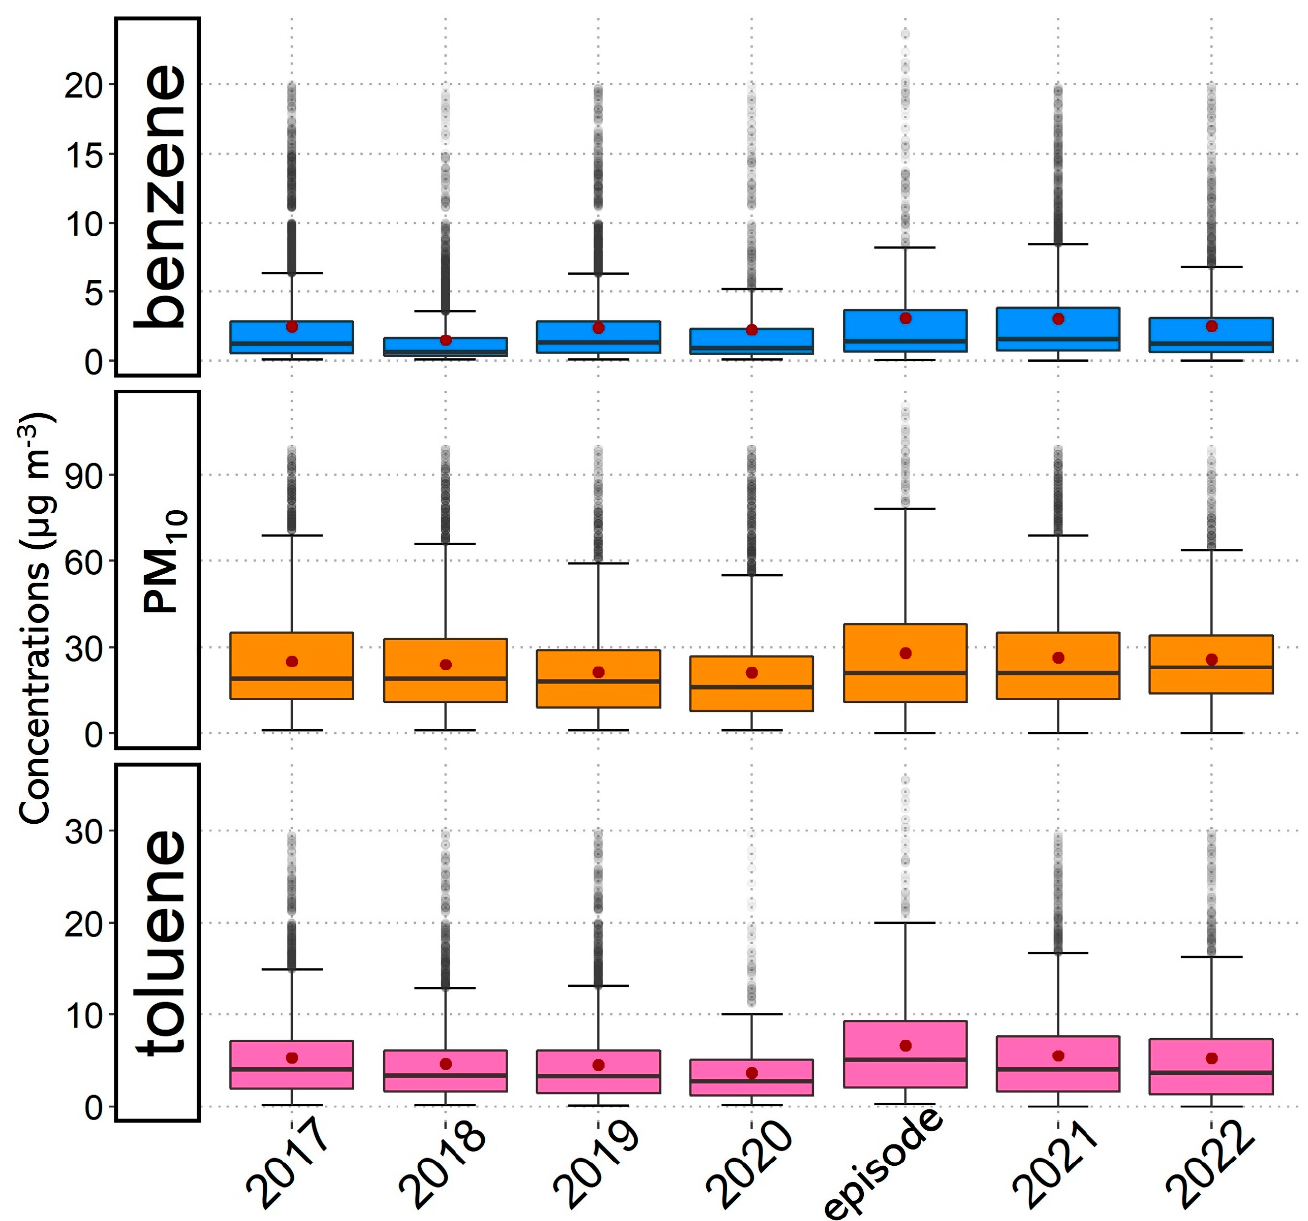
Figure 3. Annual boxplots of 1 h concentrations ( µ g m − 3 ) for PM 10 , benzene, and toluene at Capuava AQS, from 2017 to 2022, and for each episode. Boxplot width and the lower and upper hinges correspond to the first and third quartiles (the 25th and 75th percentiles). Lower whisker: smallest observation greater than or equal to lower hinge—1.5 * IQR (interquartile range), above 75th percentile. Upper whisker: largest observation less than or equal to upper hinge + 1.5 * IQR, below 25th percentile. The middle is the median (50% quantile), and the red point is the mean value. Points beyond the end of the whiskers are “outliers”, which correspond to values > 1.5 and <3 times the standard deviation (sd). The data were presented on the Y axis with an appropriate scale for good visualization of the percentiles and the mean in relation to the median. Obs.: The episode corresponds to April–May of 2021, 2021 corresponds to the other months of this year, the data available for 2020 were only from January to March, and 2022 was only from January to June. The normalized concentrations in relation to the mean value profiles of PM 10 , benzene, and toluene from April to May for each year from 2017 to 2022 are presented in Figure